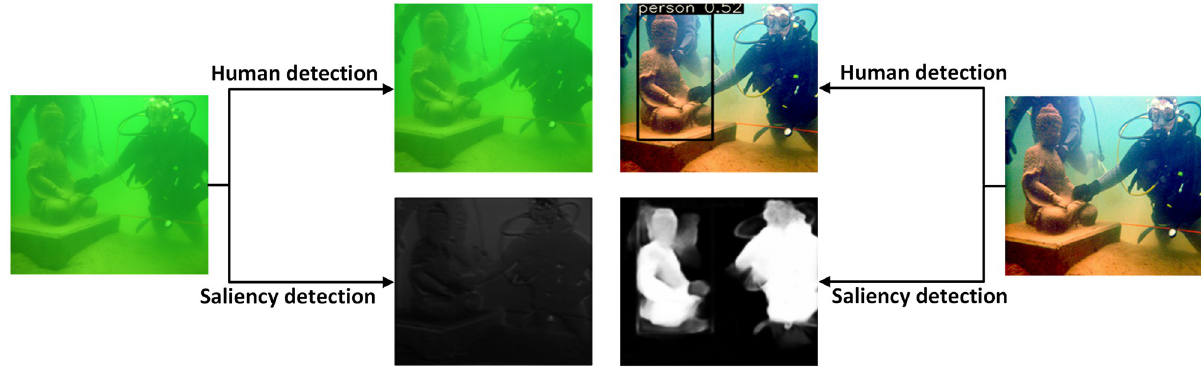
Fig 13. Human and saliency target